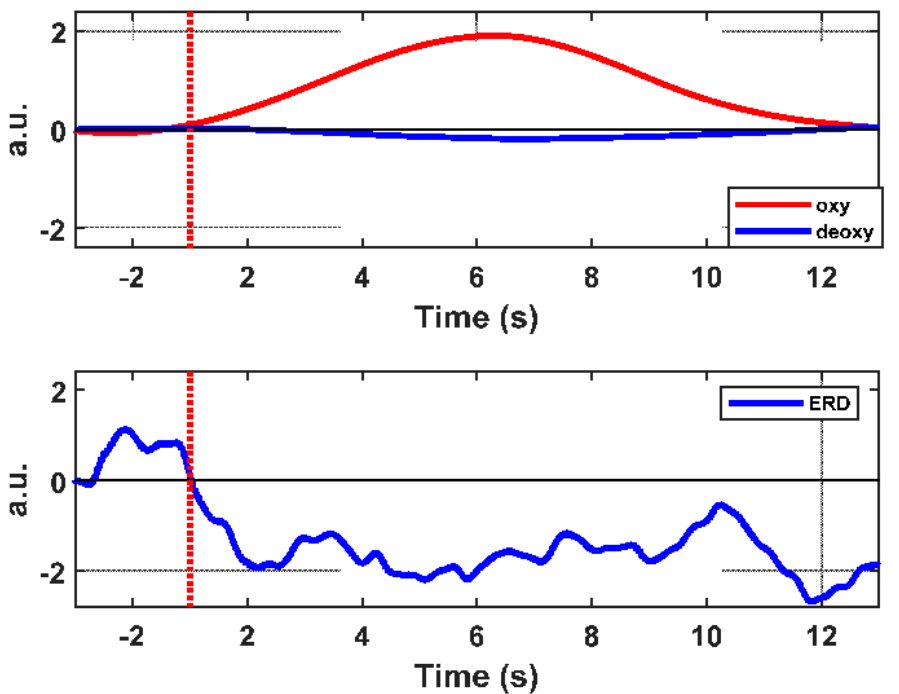
Table 4. Correlation coefficients of the alpha wave with deoxyHb in the RPMCdr cortical area during LF.